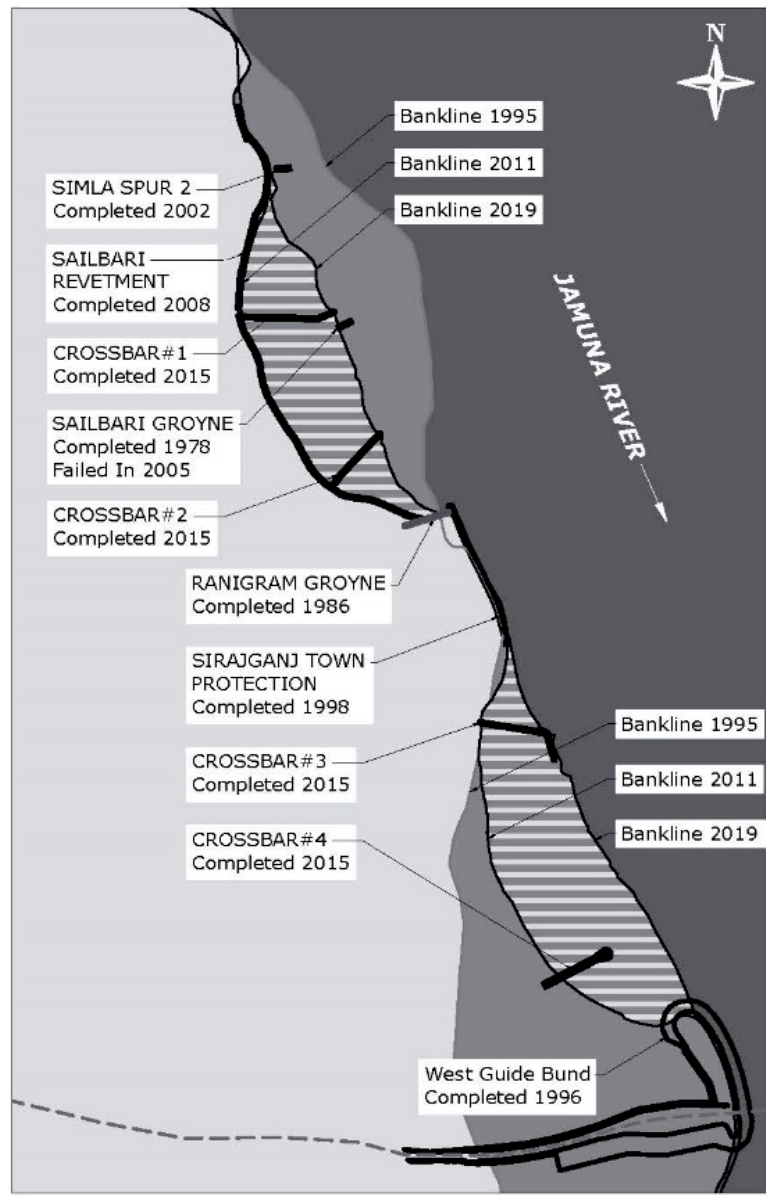
Figure 6. Forty years of developments at Sirajganj.